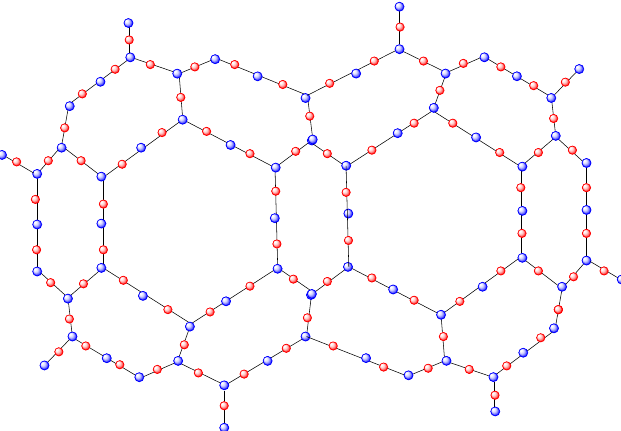
Figure 3. Subdivision of H 3 BO 3 .